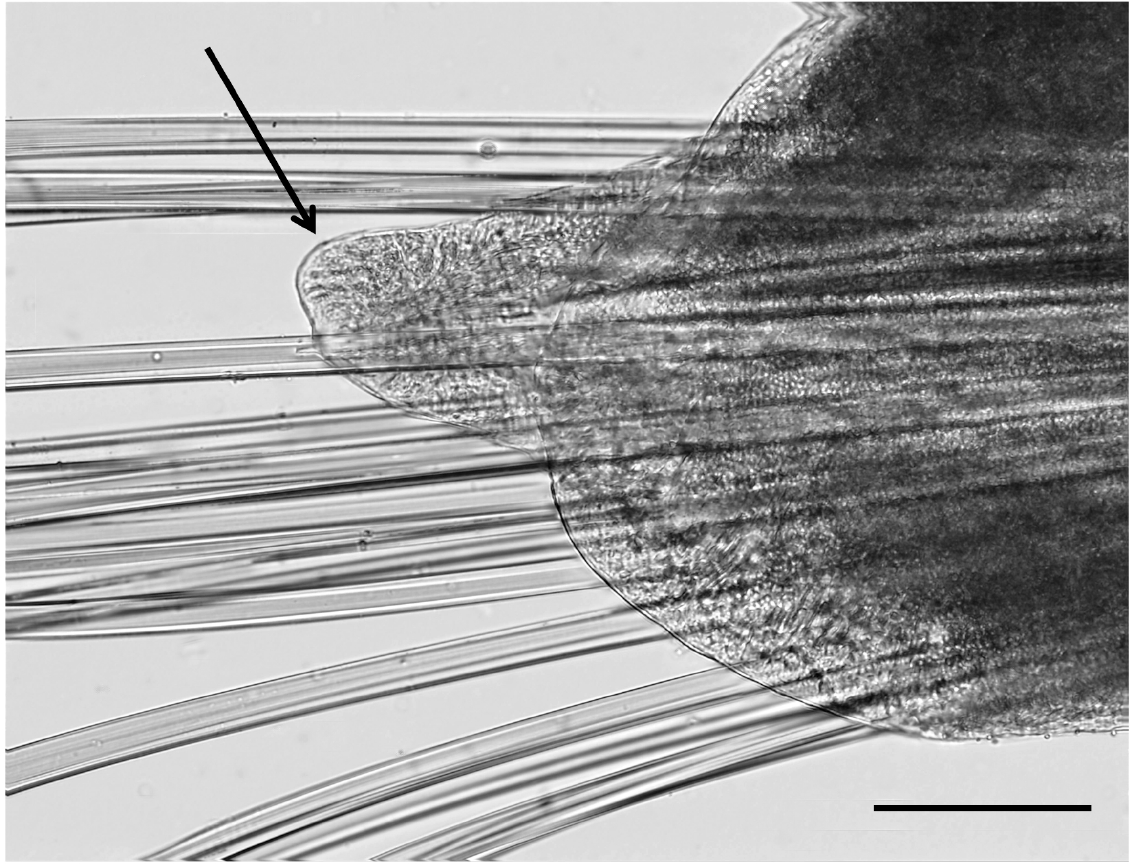
Fig. 5. Webbnesia maculata gen. et sp. nov., holotype (TFMCBM-AN/246). Distal part of neuropodium (posterior view), showing shorter rounded postchaetal lobe and elongate prechaetal acicular lobe with minute supra-acicular process (arrow). Scale bar = 70